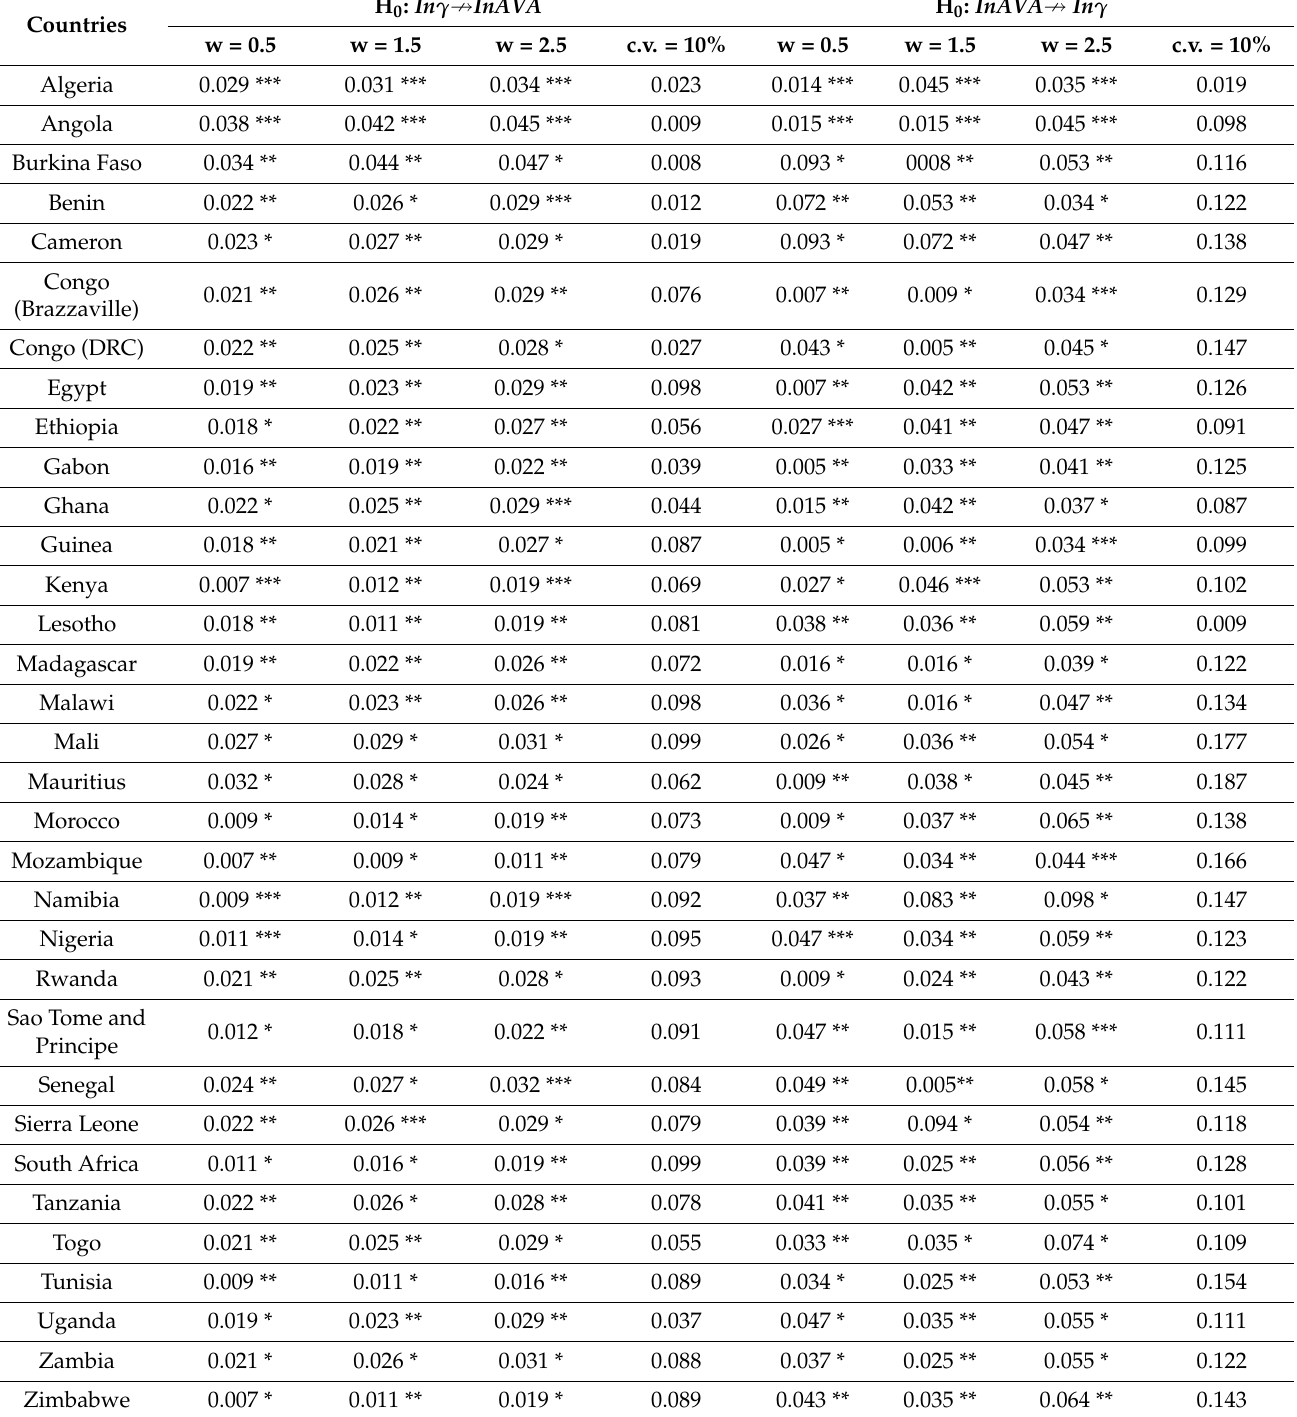
Table 7. Granger causality tests in the frequency domain estimates In γ , InAVA